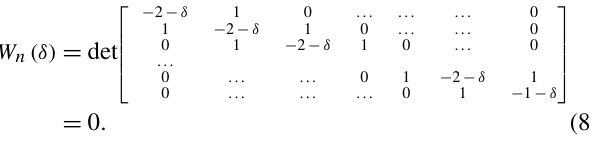
Figure 1. Conceptual model of submerged